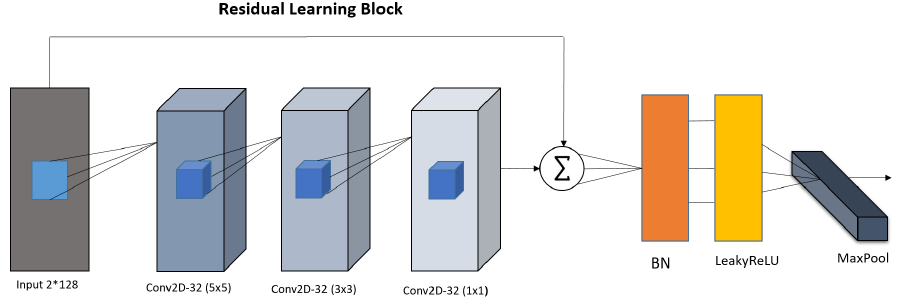
Figure 2. Residual